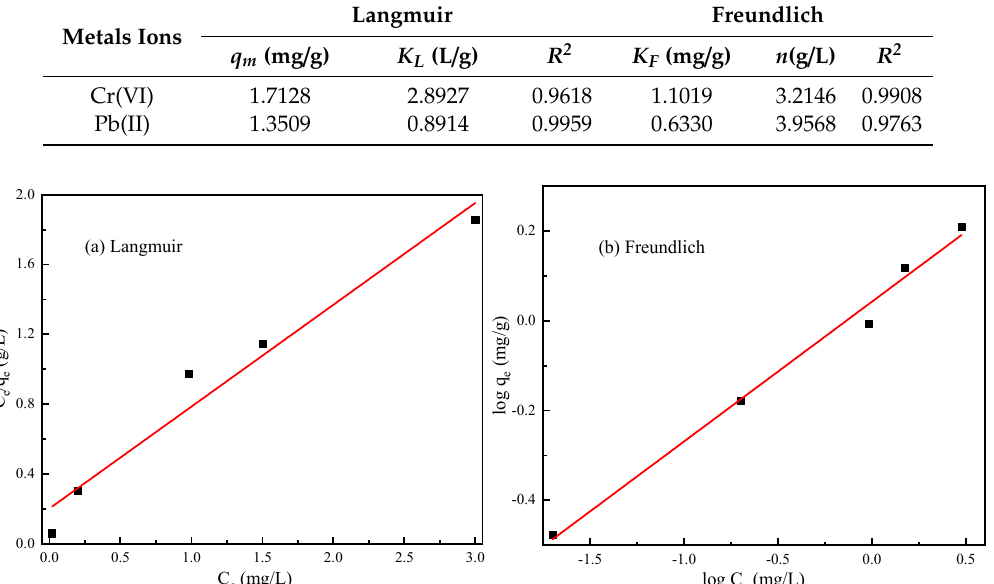
Figure 11. Langmuir ( a ) and Freundlich ( b ) isotherms for Cr(VI) adsorption by Fe-REC. Minerals 2020 , 10 , x FOR PEER REVIEW